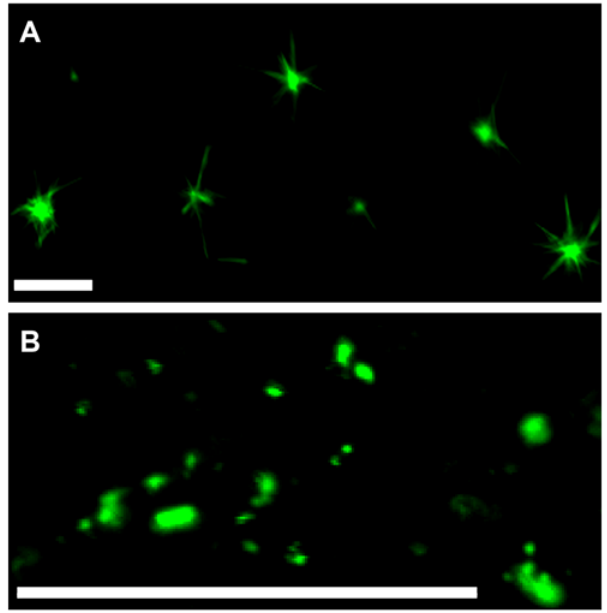
Figure 7. Perinuclear-distributed VER2-GFP is associated with microtubules in transgenic Arabidopsis . (A) Epidermal cells treated with DMSO (1%) for 30 min. (B) Epidermal cells treated with PPM (5 m M) for 30 min. Bars, 20 m